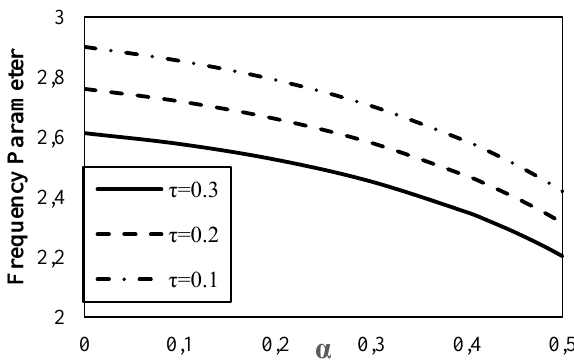
Figure 14: Dimensionless frequency vs. attached mass ratio. ( L / h = 10 , V = 0.2 , K w K p = 20 , ∆T = 10 ∘ , ∆H = 10 )